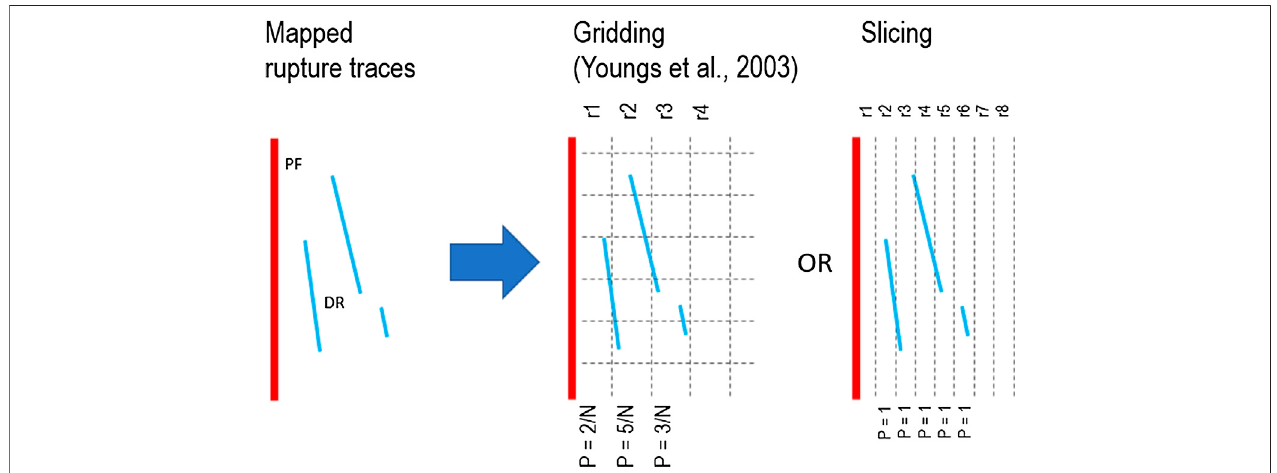
FIGURE3| Principleof “ slicing ” incomparisontogridding.Fromthemapviewtheoccurrenceofthedistributedruptures(bluelines)isanalyzedinacell(gridding)or within a slice (slicing) parallel to the principal fault (red line). The approach used for obtaining the probability of DR occurrence in slicing is independent of the fault-normal division into grids, and the completeness of the rupture